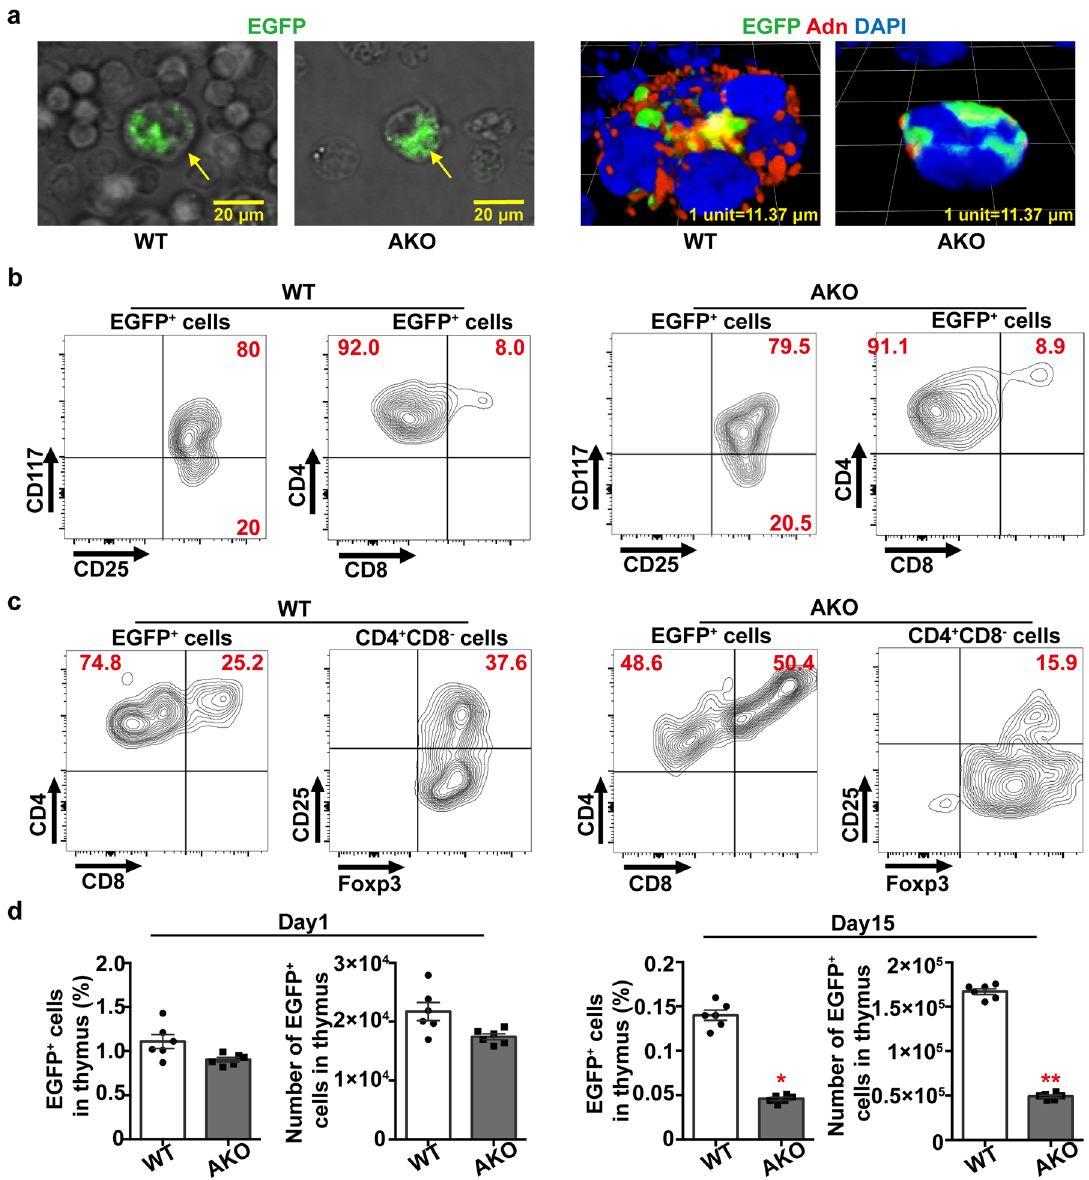
Fig. 3 Adiponectin-expressing thymocytes are tTreg precursors. a EGFP + cells collected from the thymus of Adn-Cre/ROSA mT/mG mice were injected [30000 cells/ mouse via tail vein] into WT or AKO recipient mice, which were subjected to a sub-lethal 5 Gy γ -radiation. At 12 h after adoptive transfer, cell suspensions were prepared from the thymus of the recipient mice for visualizing the EGFP + cells ( left ) and immuno fl uorescence staining for adiponectin protein ( right ). b At one day after cell injection, fl ow cytometry was performed to analyze the distribution of EGFP + cells in the thymus of WT ( left ) and AKO ( right ) recipient mice, after staining with antibodies recognizing CD117, CD25, CD4, and CD8. c At 15 days after injection, fl ow cytometry was performed to analyze the distribution of EGFP + cells in the thymus of WT ( left ) and AKO ( right ) recipient mice, after staining with antibodies recognizing CD4, CD8, CD25, and Foxp3. d The percentage contents and total numbers of EGFP + cells in the thymus of WT or AKO recipient mice were calculated based on fl ow cytometric results at day one and 15 after adoptive transfer. Data are presented as mean ± SEM. *, P < 0.05 and **, P < 0.01 vs corresponding WT controls (n = 6 biologically independent samples from different animals of independent